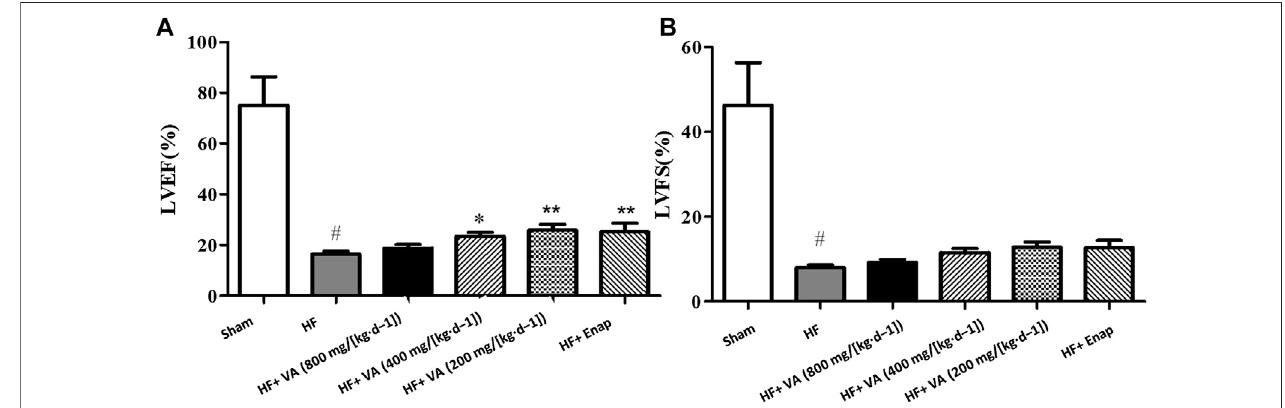
FIGURE 1 | The effects of velvet antlers (VA) on the left ventricular ejection fraction (LVEF) (A) and left ventricular fractional shortening (LVFS) (B) . The data are expressed as means ± SEM. #: p < 0.05 vs. the sham group; *: p < 0.05 vs. the heart failure (HF) group; **: p < 0.01 vs. the HF group; n (cid:1) 6. Enap: enalapril.